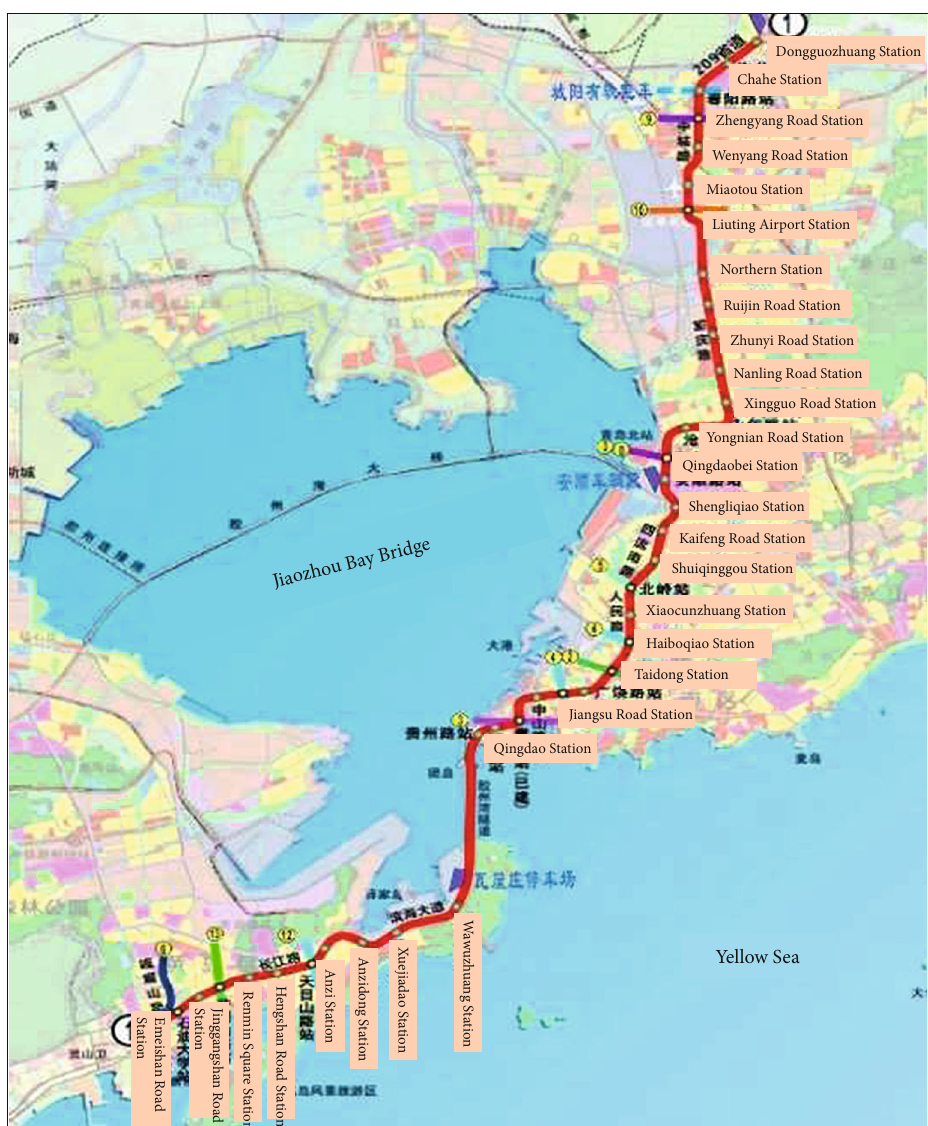
Figure 1: Qingdao Metro Line 1 fl oor